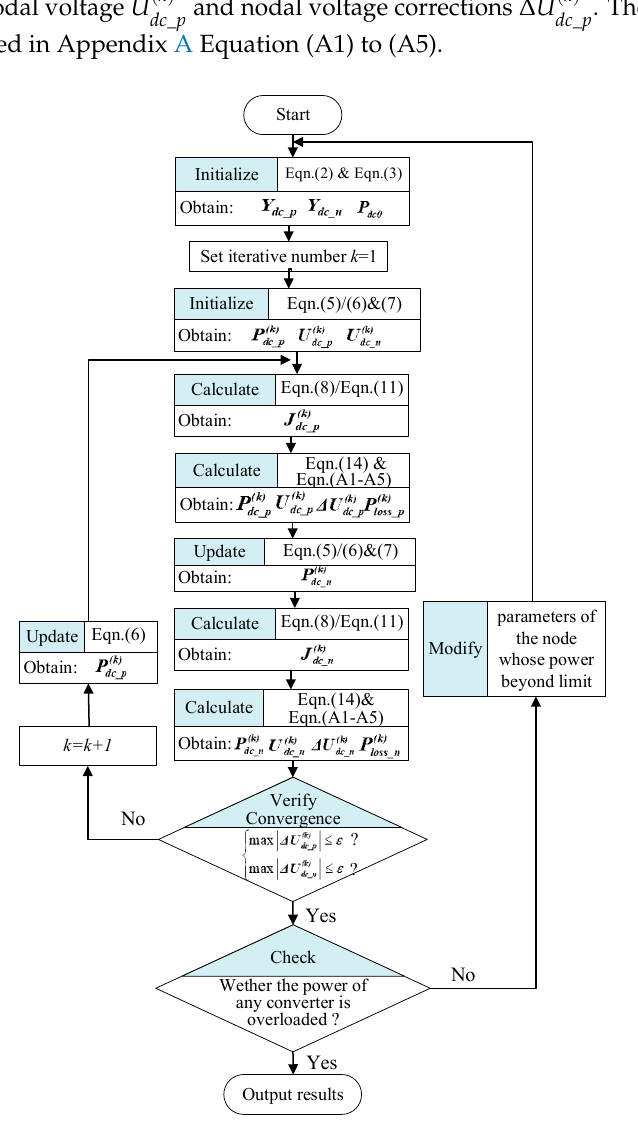
Figure 6. Power flow calculation procedure.